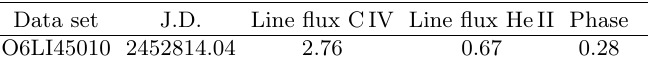
Table 8. Line (cid:13)uxes of AN UMa from the HST spectra. The integrated (cid:13)uxes are in units of 10 (cid:0) 13 erg cm (cid:0) 2 s (cid:0) 1 . Data